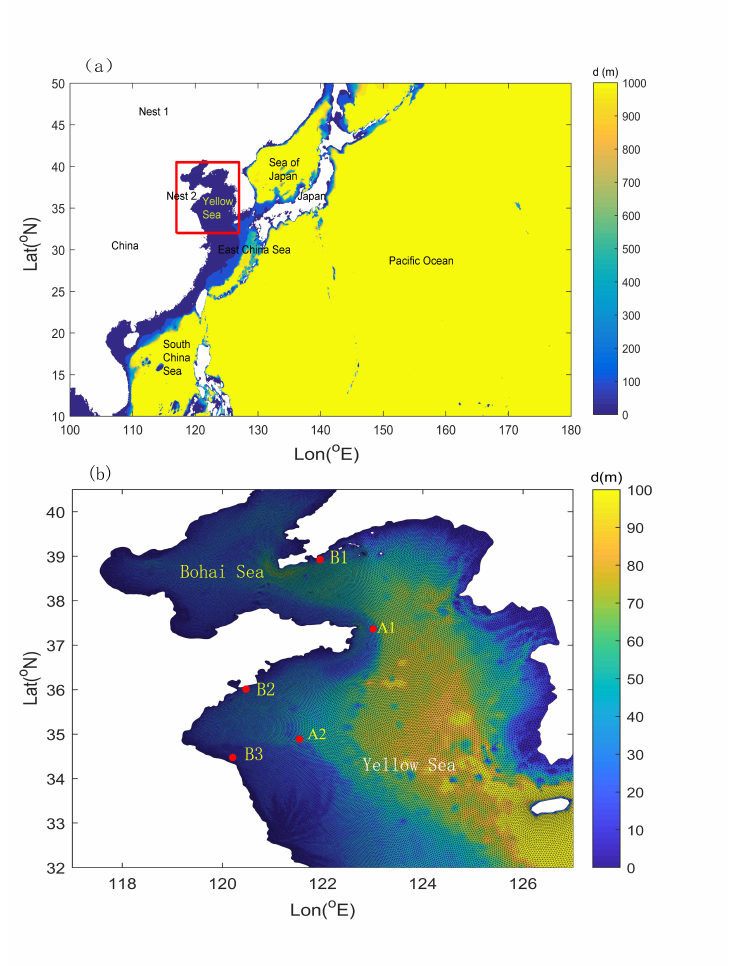
Figure 1. Implementation areas and Nest 2 mesh for TOMAWAC model (( a ) Domain for Nest 1; ( b ) Domain for Nest